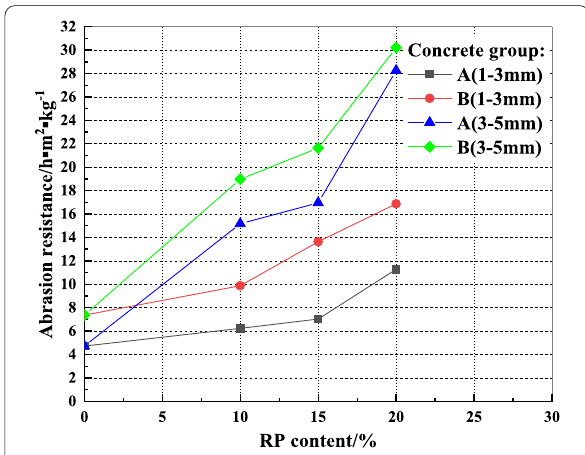
Fig. 15 Relationship between the abrasive resistance of concrete and RP content